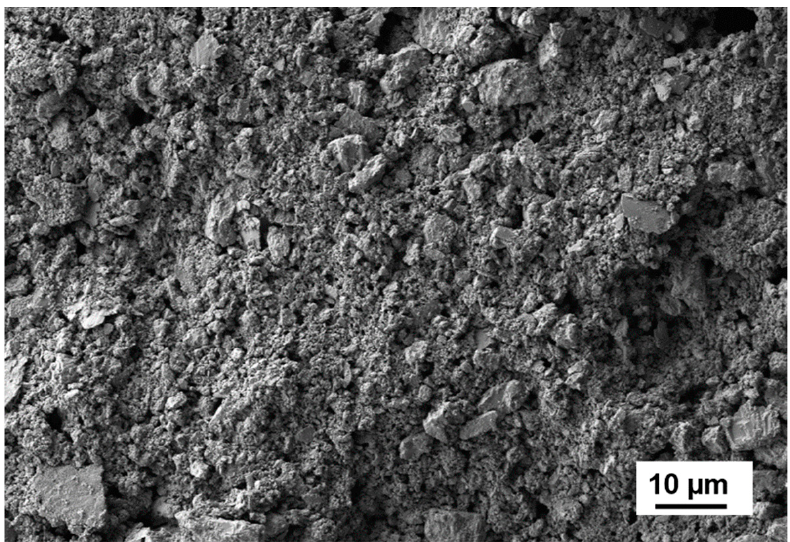
Figure 7. SEM image of the Ti 1 − x Al x N powder after pulverizing in a mortar.